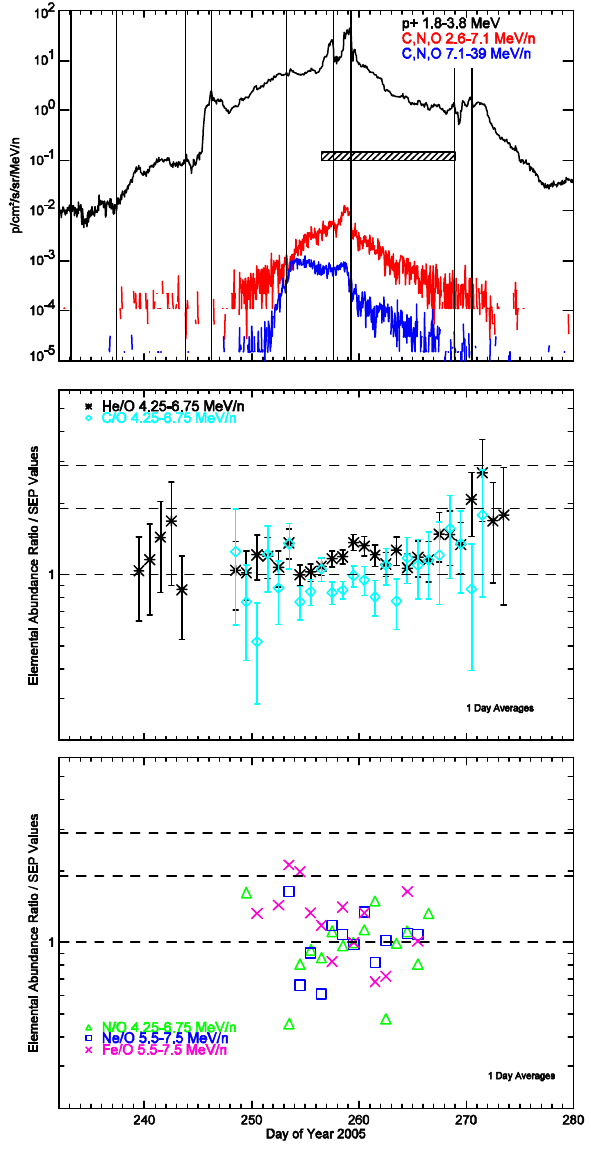
Figure 4a. (Top panel) The three traces from top show 1.8-3.8 MeV proton intensity and the Fig. 4a. (Top panel) The three traces from top show 1.8–3.8MeV proton intensity and the heavy ion intensities in the 2.6–7.1MeV/n heavy ion intensities in the 2.6-7.1 MeV/n and 7.1-39 MeV/n energy intervals for the charge and 7.1–39MeV/n energy intervals for the charge group C,N,O as group C,N,O as measured by the COSPIN/LET for the period DOY 232-280. (Middle and measured by the COSPIN/LET for the period DOY 232–280. (Mid- dle and bottom panels) Heavy ion abundance ratios (1-day averages) bottom panels) Heavy ion abundance ratios (1-day averages) in the energy range 4.25 MeV/n in the energy range 4.25MeV/n to 7.5MeV/n for helium, carbon, to 7.5 MeV/n for helium, carbon, nitrogen, neon and iron with respect to oxygen, all nitrogen, neon and iron with respect to oxygen, all normalized to the SEP composition given by Mason and Sanderson (1999). normalized to the SEP composition given by Mason and Sanderson (1999).